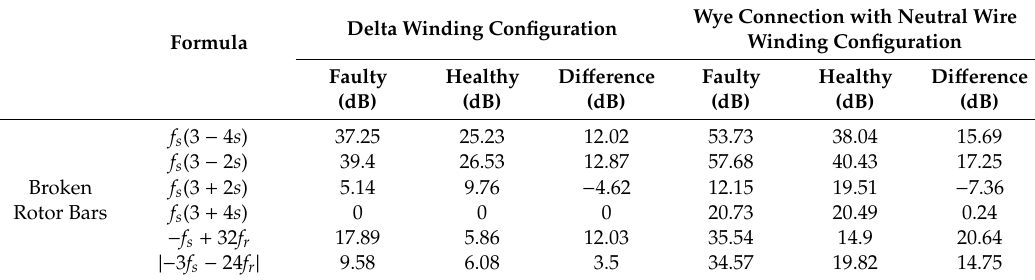
Table 6. Amplitudes of characteristic frequencies of the measured ZSC for a rotor cage